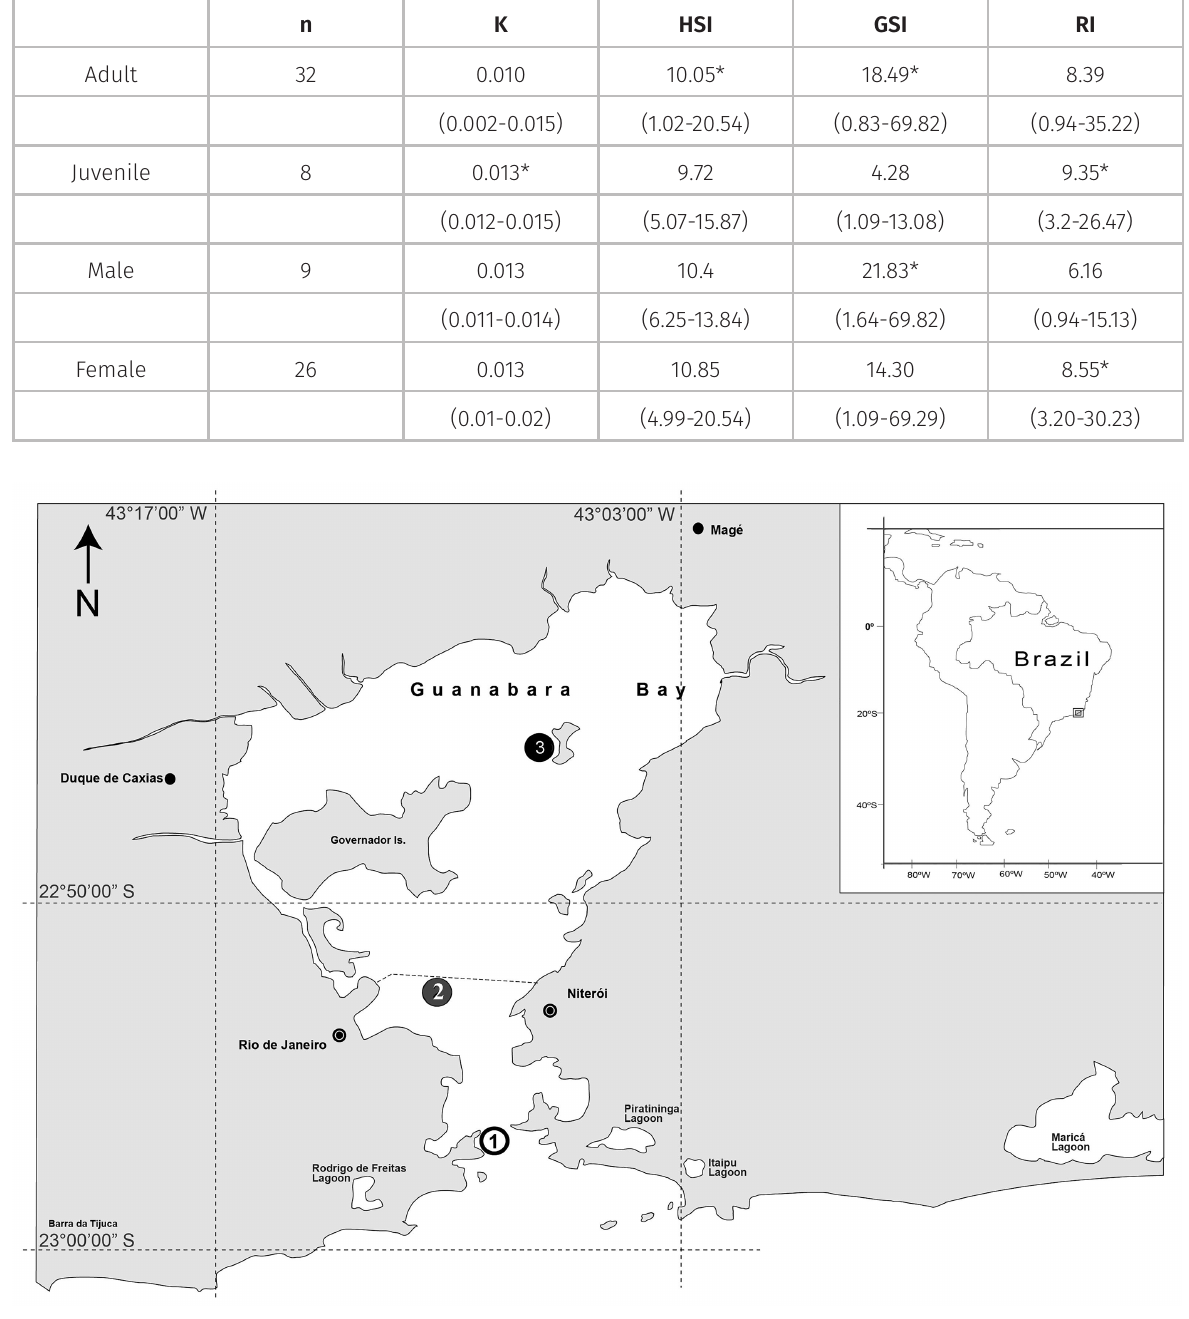
Figure 1. The geographic location of Guanabara Bay (Southeastern Brazil), showing the sites where Orthopristis ruber were caught. 1 = Urca region, located near the mouth of Guanabara Bay; 2 = site located over the main circulation channel, near the Rio-Niterói Bridge; 3 = site located near the Paquetá Island, the innermost region of Guanabara Bay undergoing direct influence by the main circulation